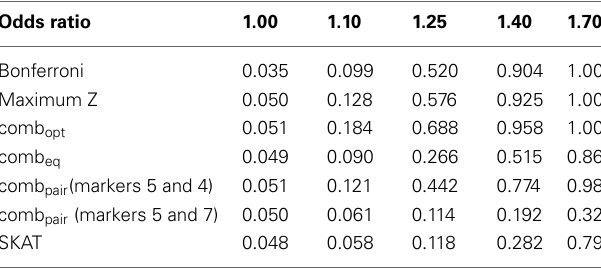
Table 1B | Estimated type-I errors (for OR = 1 . 00) and power ( OR = 1 . 10, 1.25, 1.40 and 1.70) for different methods of addressing multiple comparisons in the eight marker LD block.